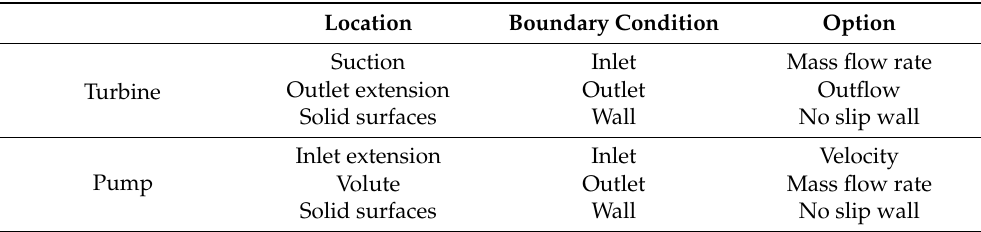
Table 2. Boundary conditions used in the numerical simulation